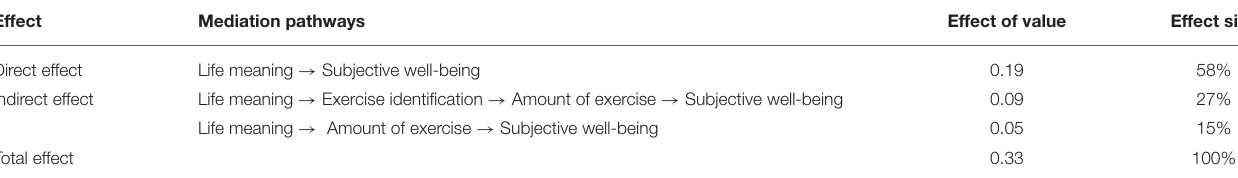
TABLE 5 | Mediation effect and effect size of the serial multiple mediation model.